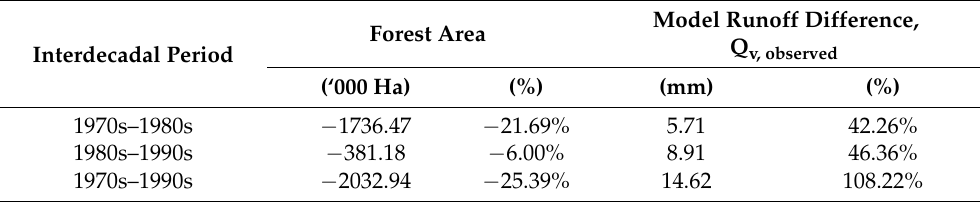
Table 7. The decadal changes in the amount and the corresponding percentage of forest area and runoff difference in Peninsular Malaysia.